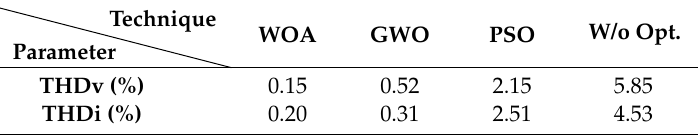
Table 3. THD values of supplied voltage and